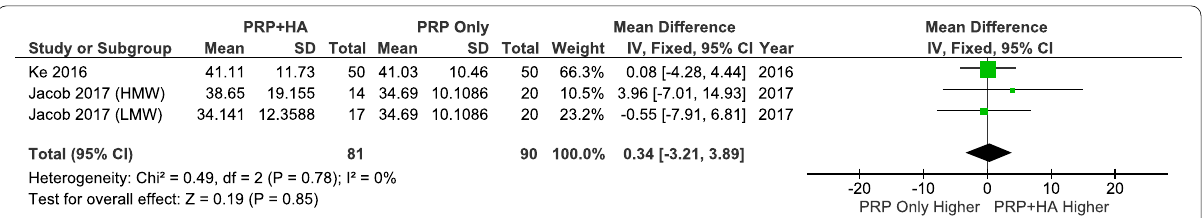
HA and PRP at baseline +